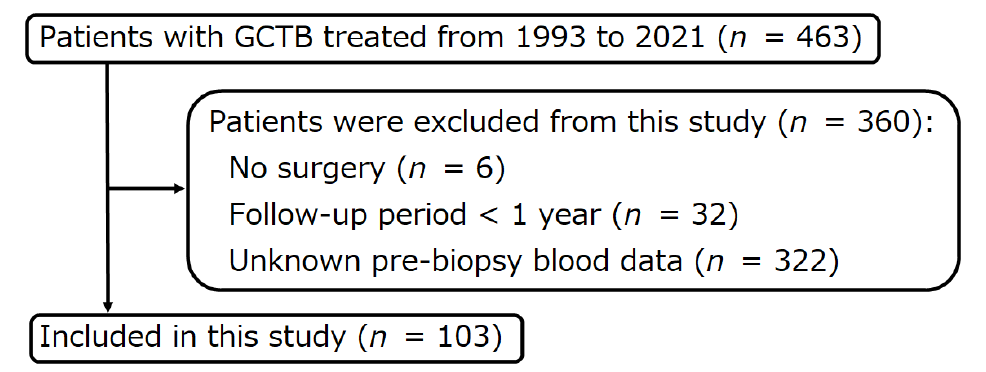
Figure 1. Flow diagram of patients with giant cell tumor of bone treated between 1993 and 2021.